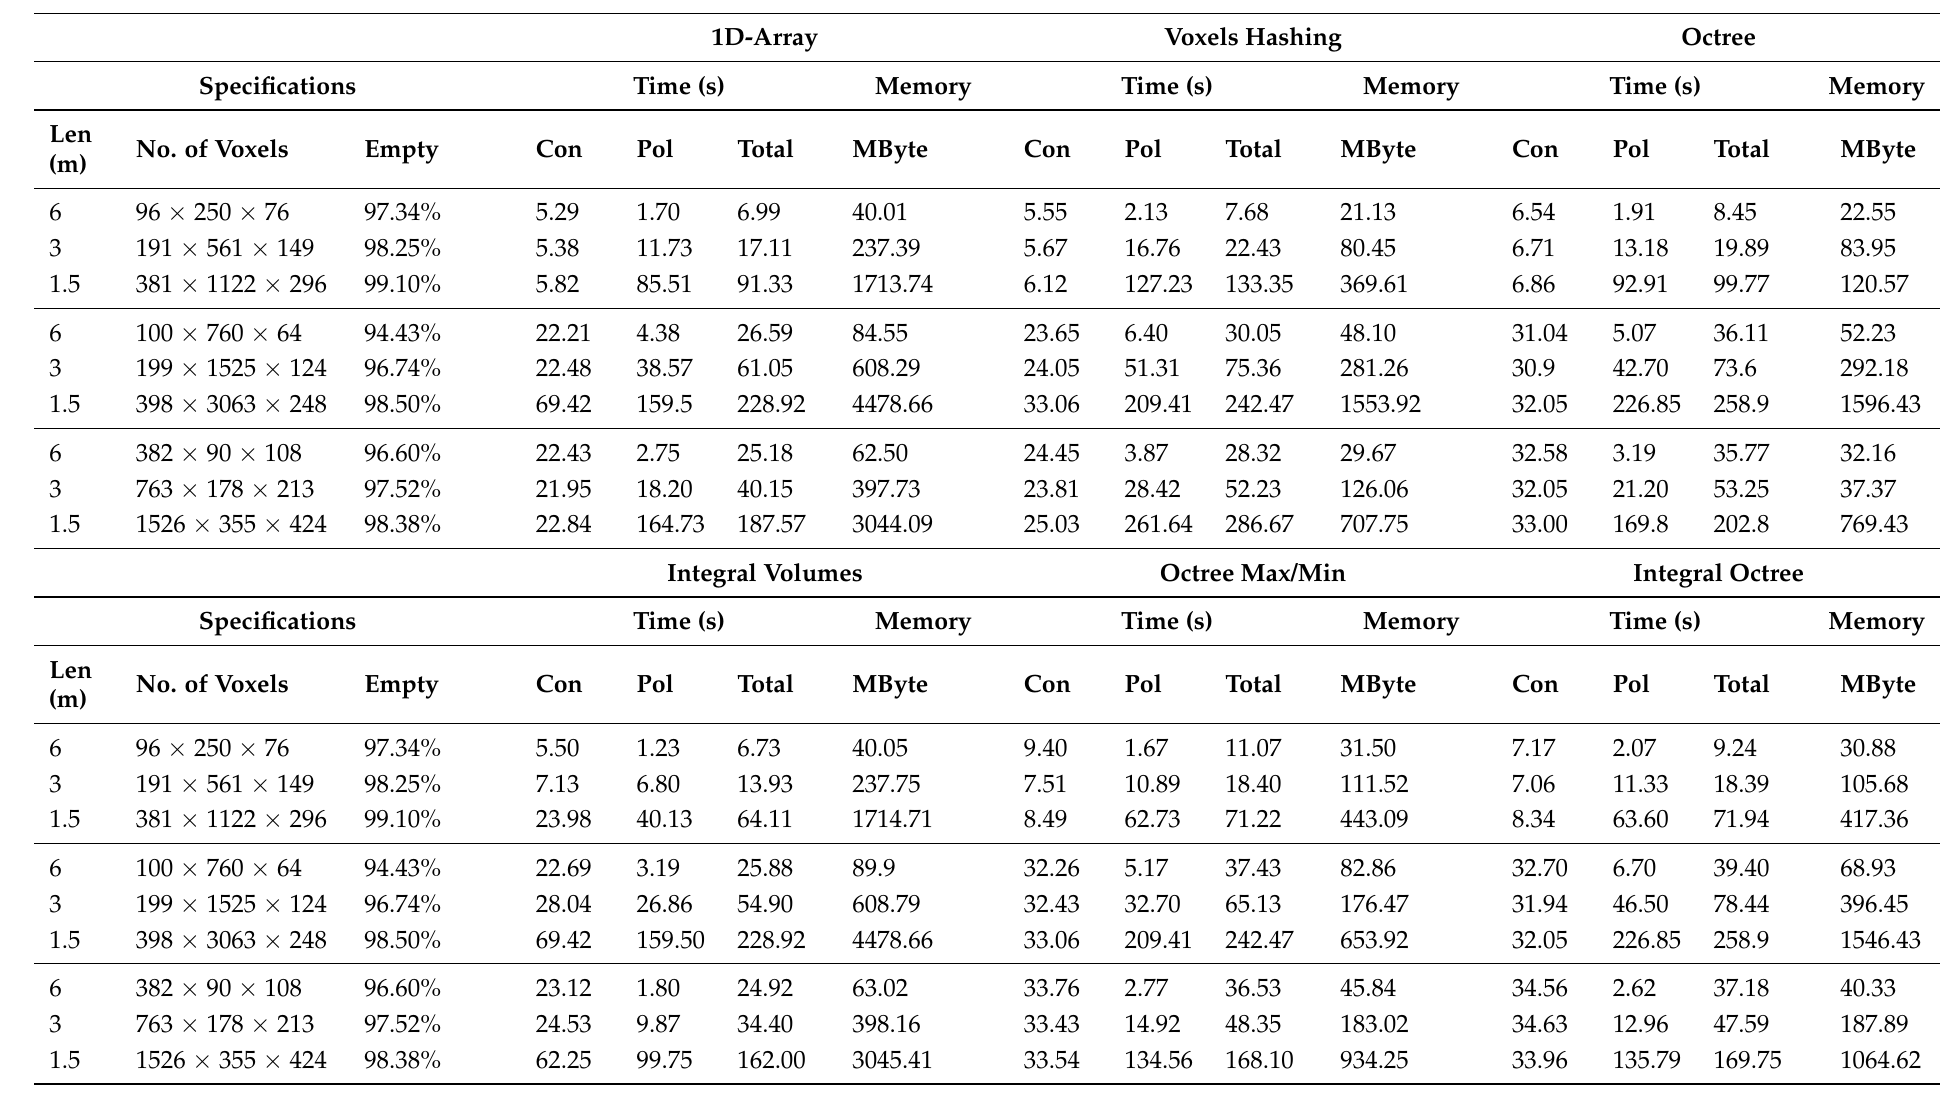
Table 5. Execution time and memory consumption results from three different